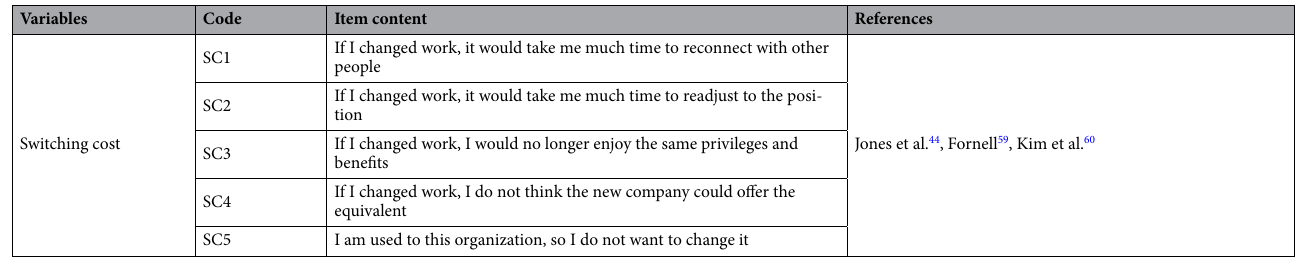
Table 1. Summary of items. Note: The Cronbach-a coefficients of employee loyalty, employee satisfaction, enterprise image, work quality and switching cost are 0.879, 0.780, 0.780, 0.835 and 0.821, respectively, and the total reliability of the questionnaire is